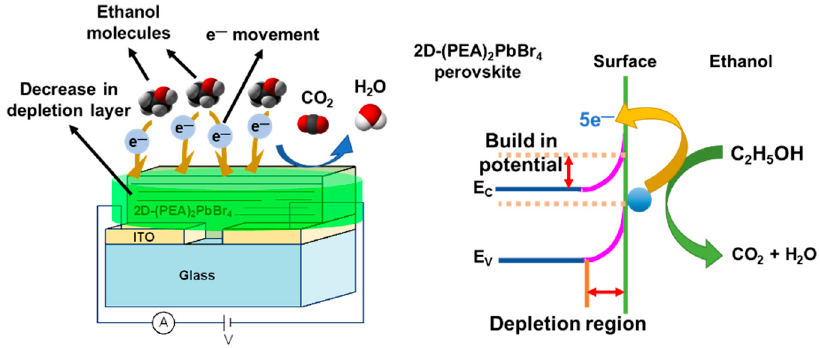
Figure 12. Schematic ethanol vapors sensing mechanism of 2D-(PEA) 2 PbBr 4 perovskite .